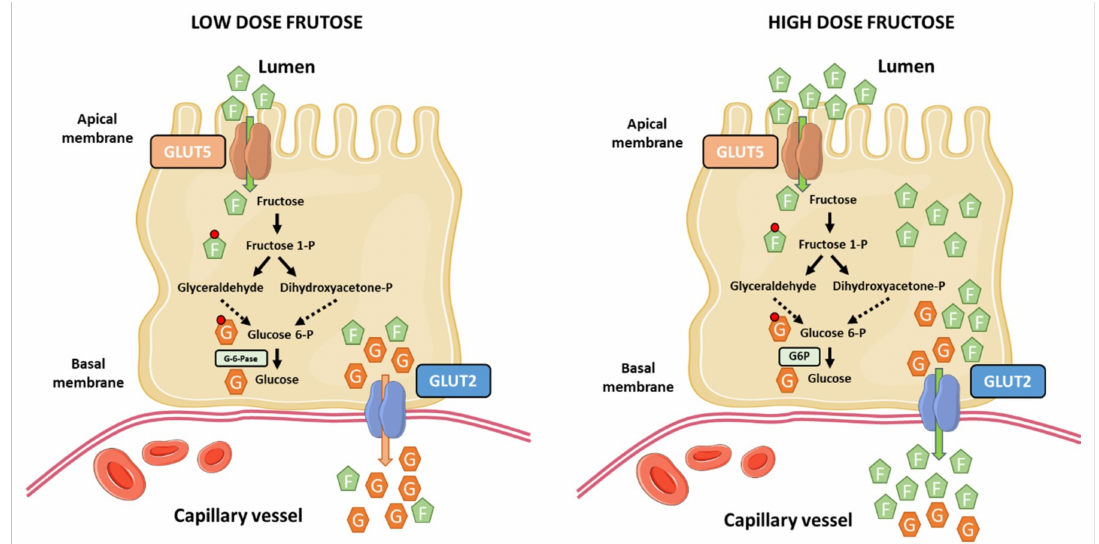
Figure 2. Current view of intestinal fructose metabolism in mice. Under conditions of low-dose dietary fructose ( F ) consumption, most of the fructose is metabolized by the Hers pathway appearing into portal circulation mainly as glucose ( G ), and the remaining as unmetabolized fructose. Conversely, under high-dose dietary fructose consumption, intestinal capacity is overwhelmed, leading to most of the fructose to spill over to the liver. Further work is needed to validate or refute this model in humans. G-6-Pase; glucose-6-phosphatase. This figure was created using Servier Medical